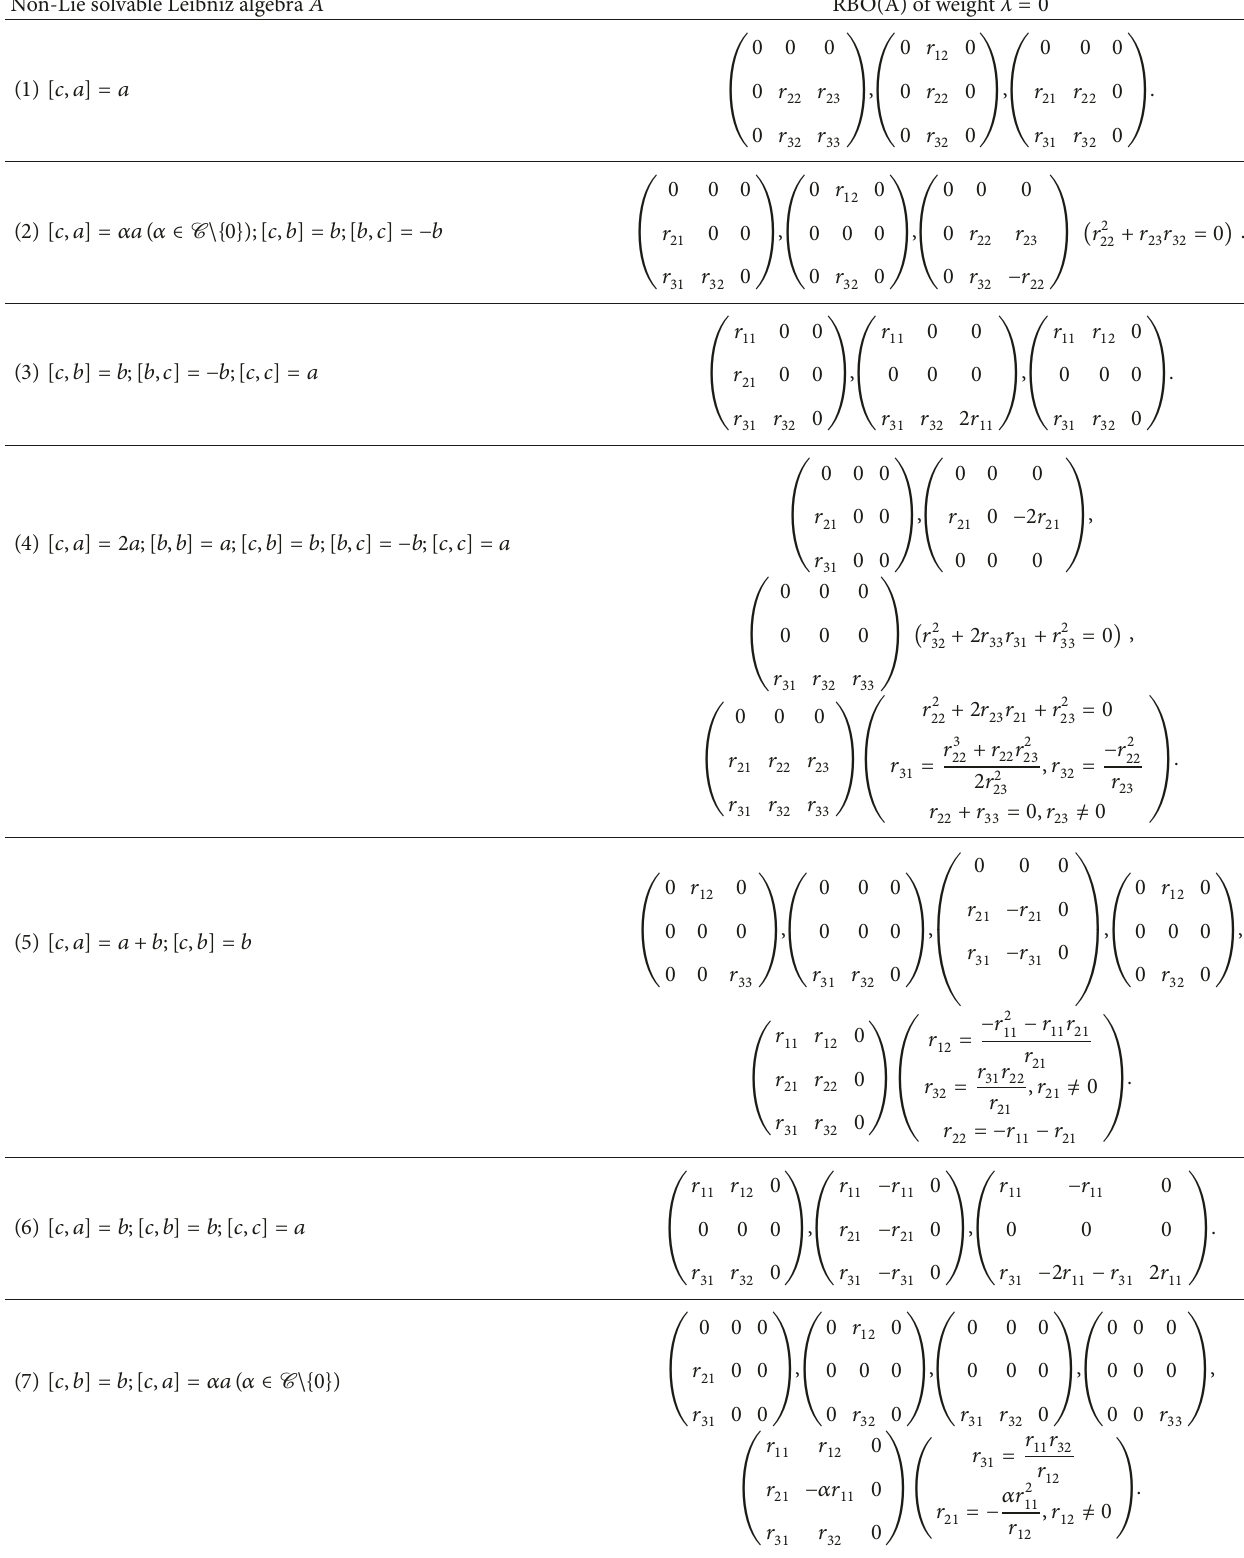
Non-Lie solvable Leibniz algebra